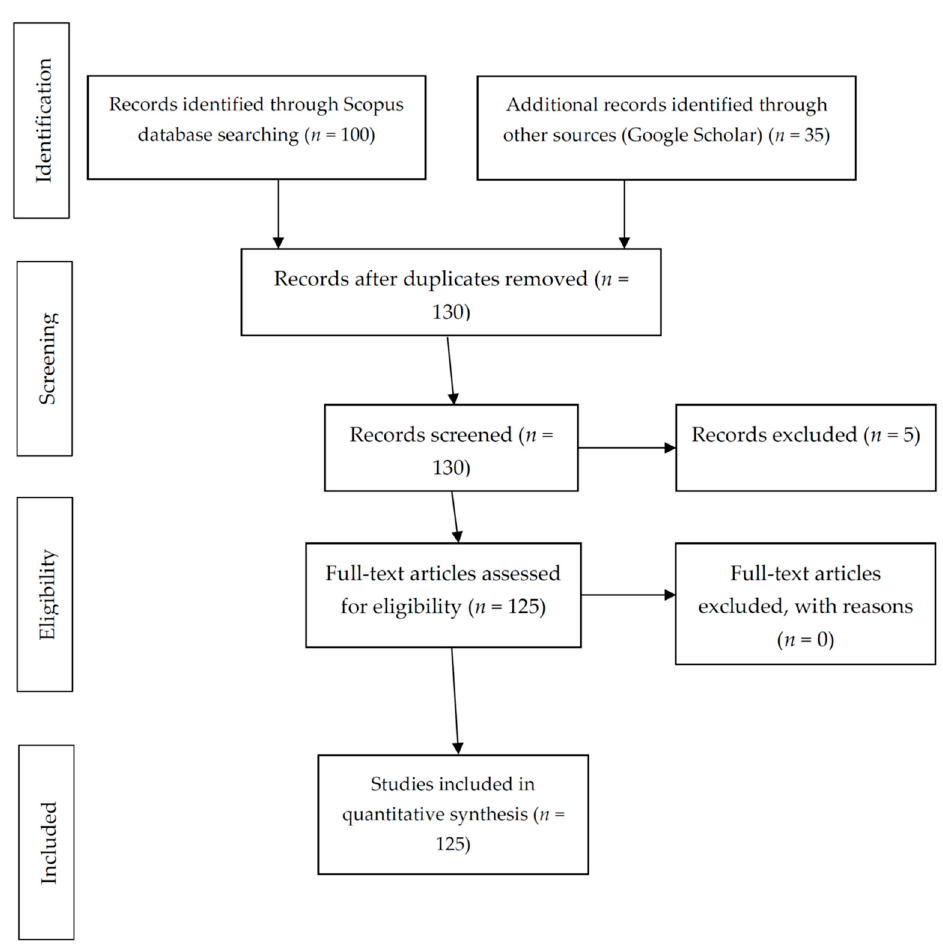
Figure 1. Flowchart of the Preferred Reporting Items for Systematic Reviews and Meta-Analyses (PRISMA) (adapted from Moher et al. [20]), used in the present study.